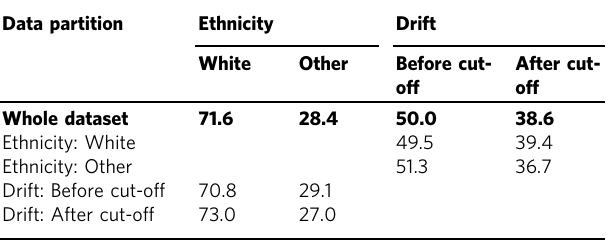
Table 4 Data partitions and